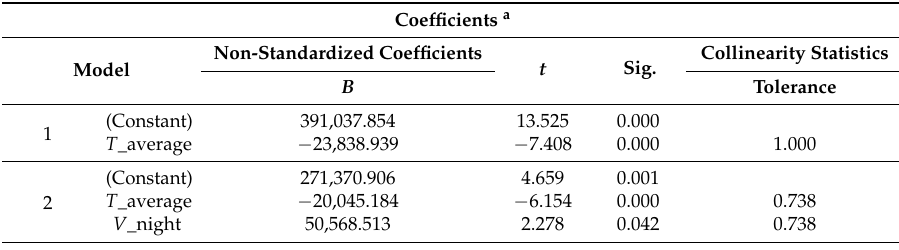
Table 6. Linear regression models. D1 building.